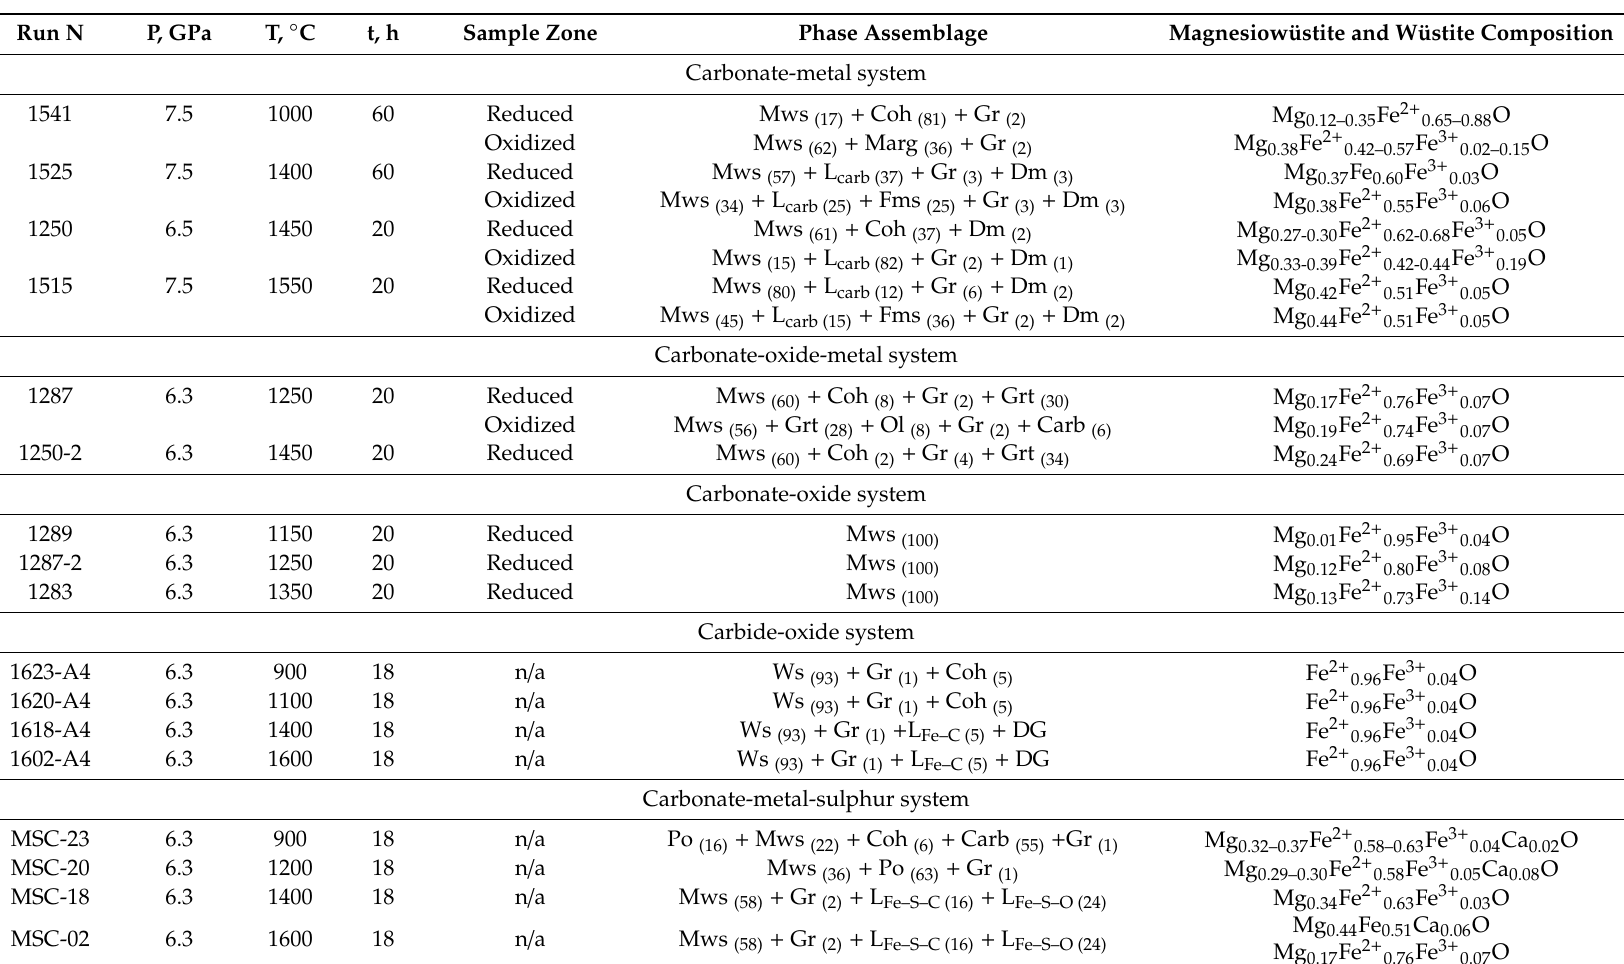
Table 1. Summary of the results of experiments in the carbonate-metal, carbonate-metal-sulphur, carbide-oxide, carbonate-oxide, carbonate-oxide-metal